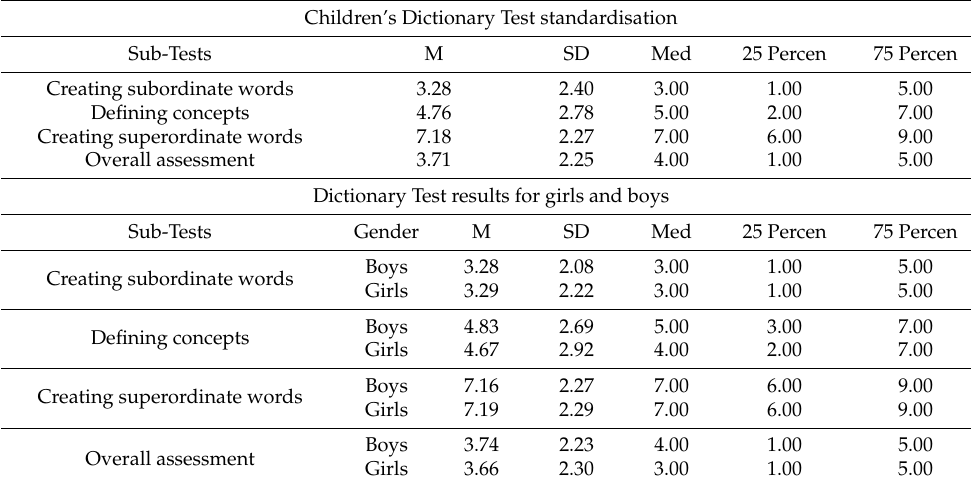
Table 1. Results of the Dictionary Test for the studied children.